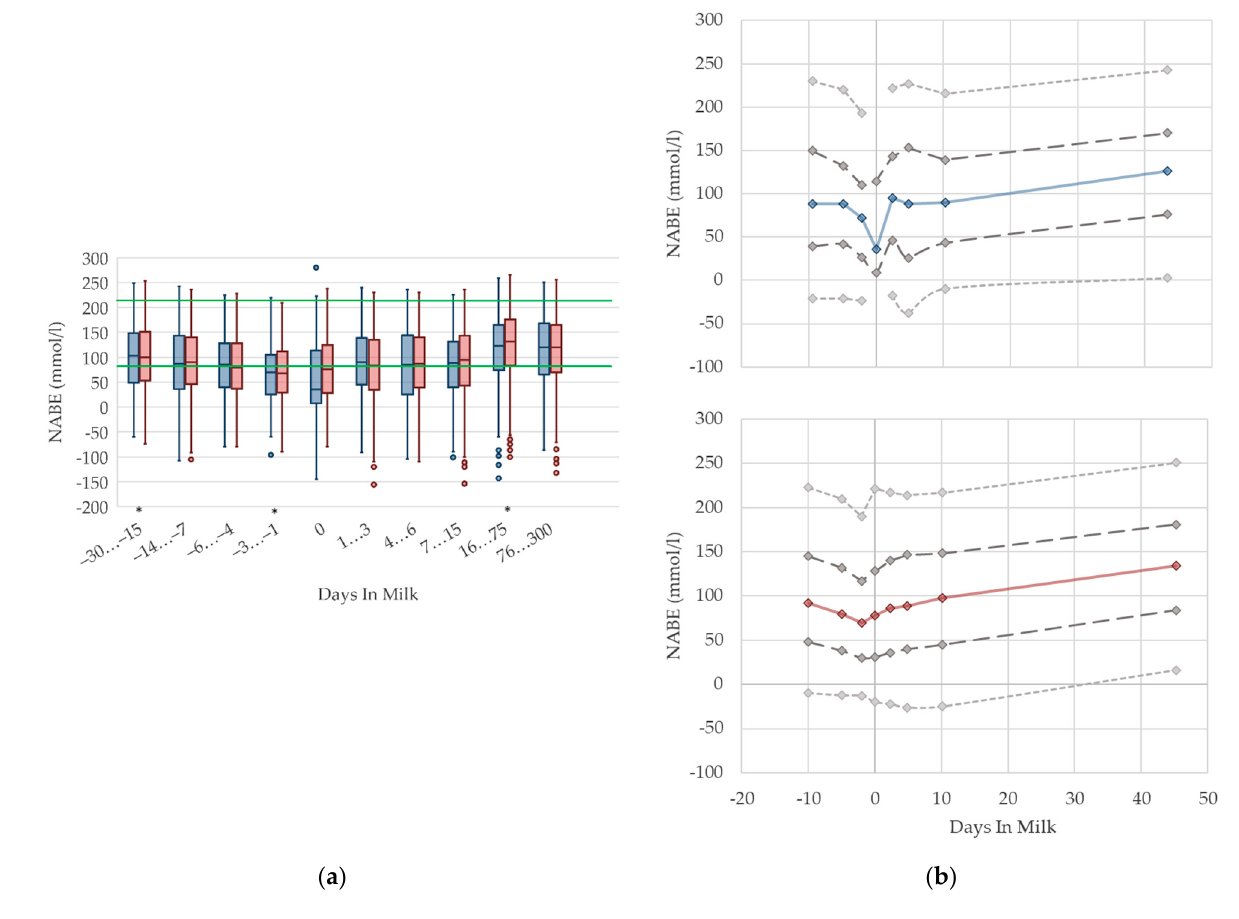
Figure 11. Urine concentrations of net acid base excretion (NABE) in primiparous (blue) and in multiparous (red) cows ( a ) in 10 classes between 30 days prepartum to 300 days postpartum (boxplots), green continuous lines represent the reference values according to Fürll [23], asterisk indicates significant differences regarding parity within DIM class; and ( b ) in 8 classes from 10 days prepartum to 40 days postpartum (median—continuous line; 1st and 3rd quartile—dashed lines; percentile 5 and 95—dotted lines).